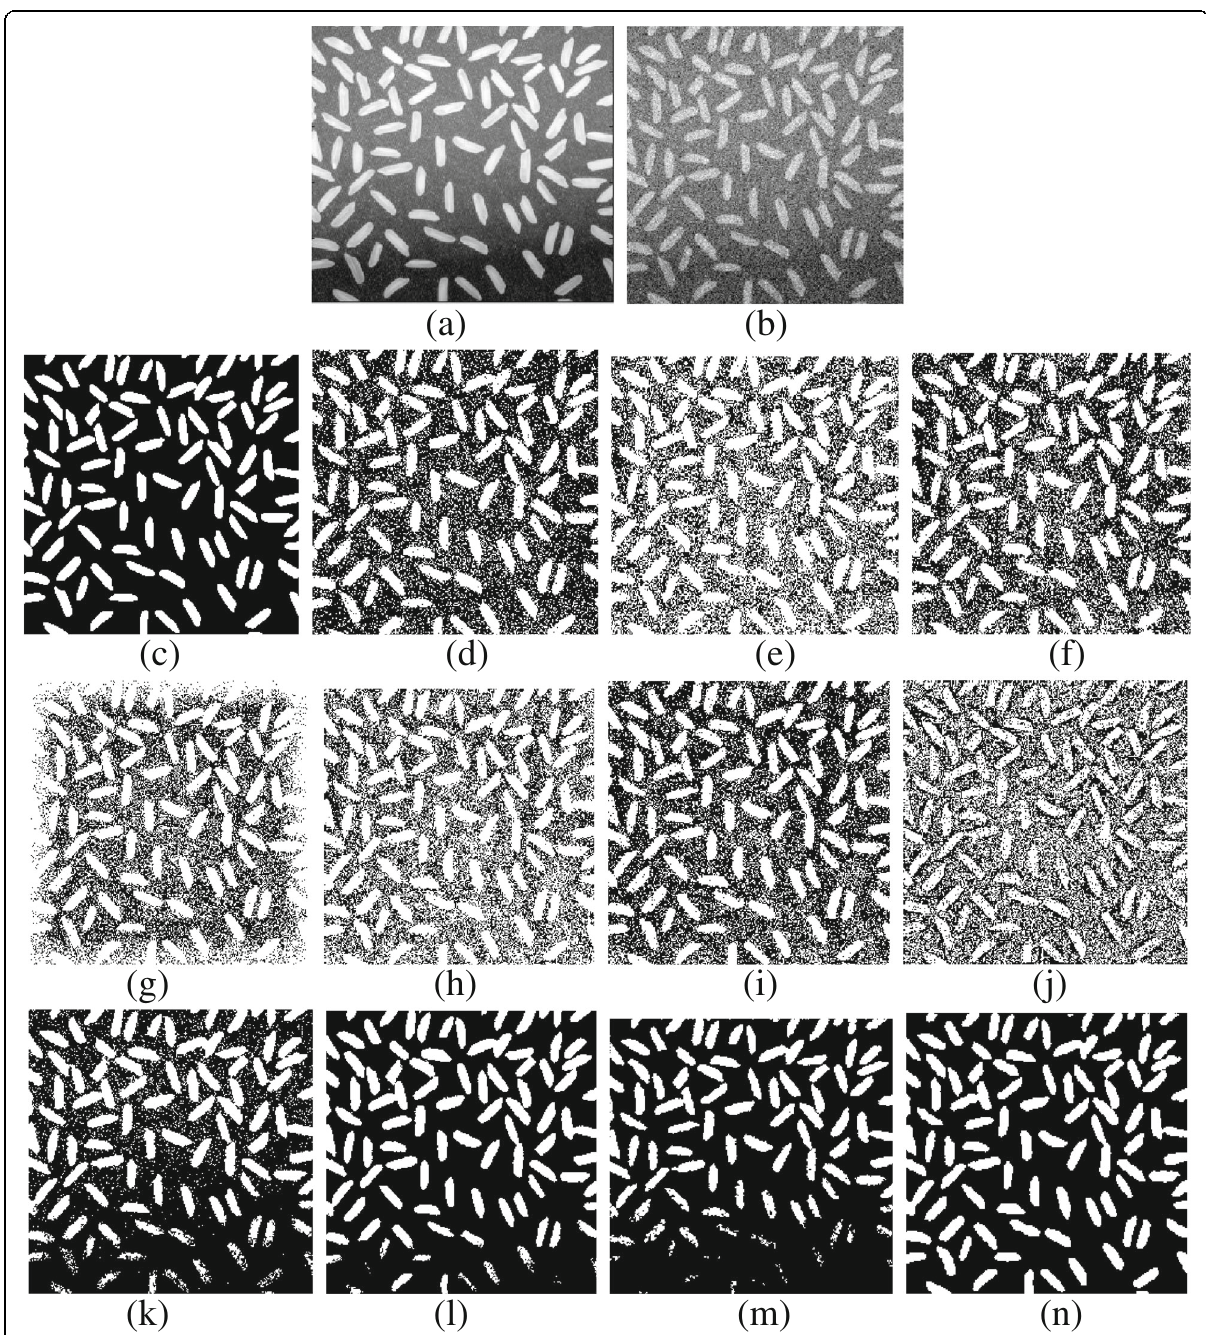
Fig. 8 Segmentation results on the rice image 256 × 256 corrupted by the Gaussian noise (0, 0.010). a Original image. b Noisy image. c Ground- truth. d Bernsen ’ s method. e Niblack ’ s method. f Sauvola ’ s method. g Bradley ’ s method. h Chou ’ s method. i Valizadeh ’ s method. j Wei ’ s